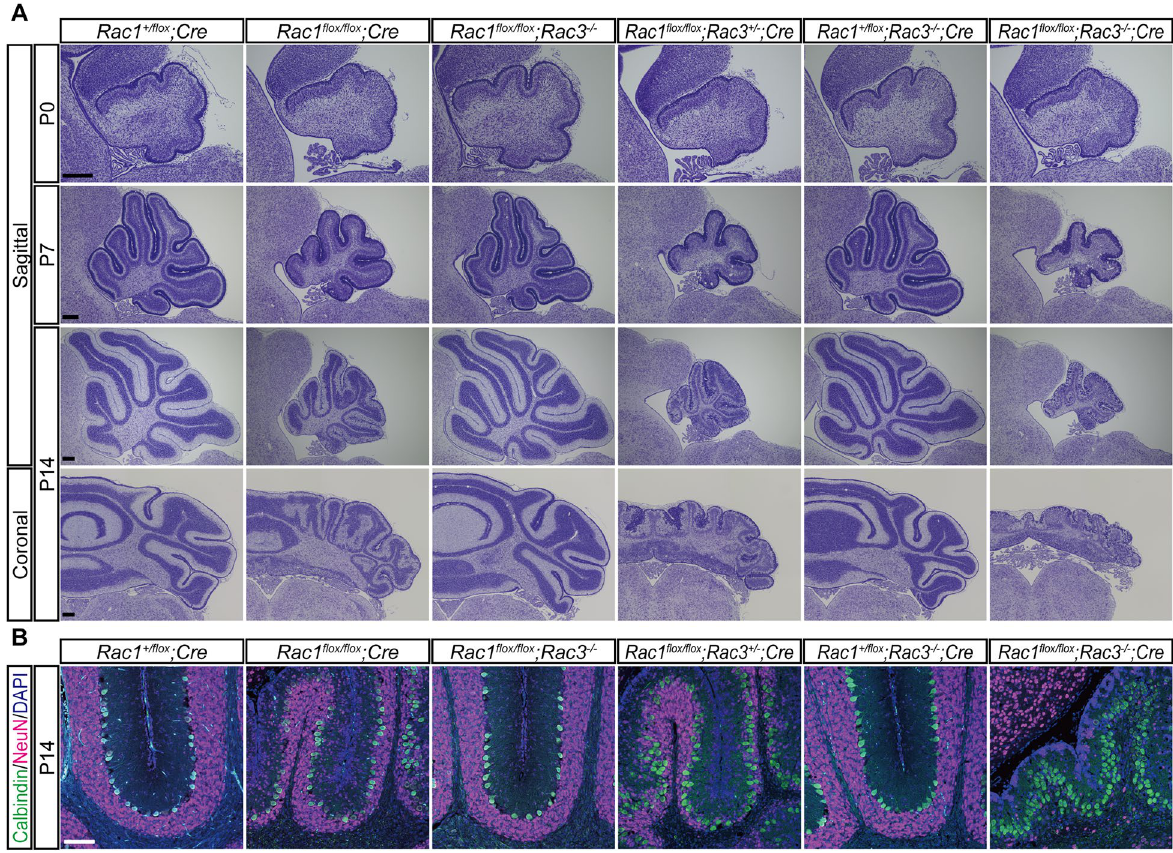
Figure 1. Deletion of Rac in cerebellar granule neurons results in loss of granule neurons. ( A ) Nissl-stained sections of the cerebellum on P0, P7 and P14. Development of the cerebellum was severely impaired in Rac1 flox/flox ; Rac3 −/− ; Cre mice. The cerebellum of Rac1 flox/flox ; Rac3 −/− ; Cre mice was slightly hypoplastic on P0, but it showed severe aplasia of the IGL in the entire cerebellum on P14. Rac1 flox/flox ; Rac3 +/− ; Cre mice showed intermediate phenotype between Rac1 flox/flox ; Cre and Rac1 flox/flox ; Rac3 −/− ; Cre mice. Rac1 + /flox ; Rac3 −/− ; Cre mice that retain only one allele of Rac1 showed morphologically normal development of the cerebellum. ( B ) Immunohistochemistry for NeuN and Calbindin around preculminate fissure of the sagittal section. NeuN- positive granule neurons were almost completely absent in Rac1 flox/flox ; Rac3 −/− ; Cre mice on P14. n = 3 animals/ genotype. Scale bars, 100